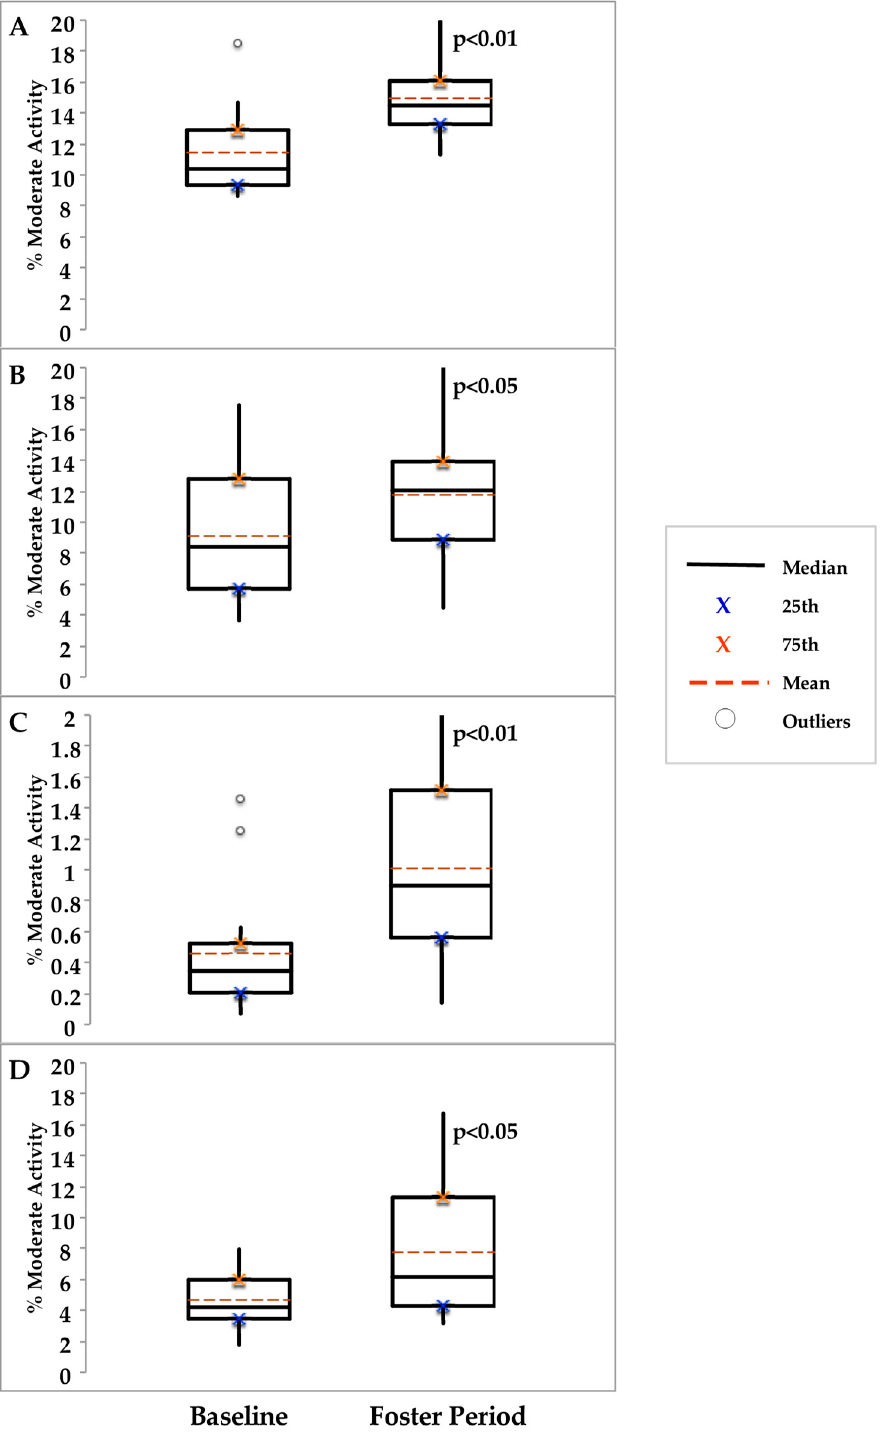
Figure 1. Percent time spent in moderate physical activity before (baseline) and during the foster period. Note: the scale for panel C units (Y-axis) is different than panels A , B, and D . The veterans were asked about their experience with the program by a person not involved in the research study. Their responses are provided in Table 4.